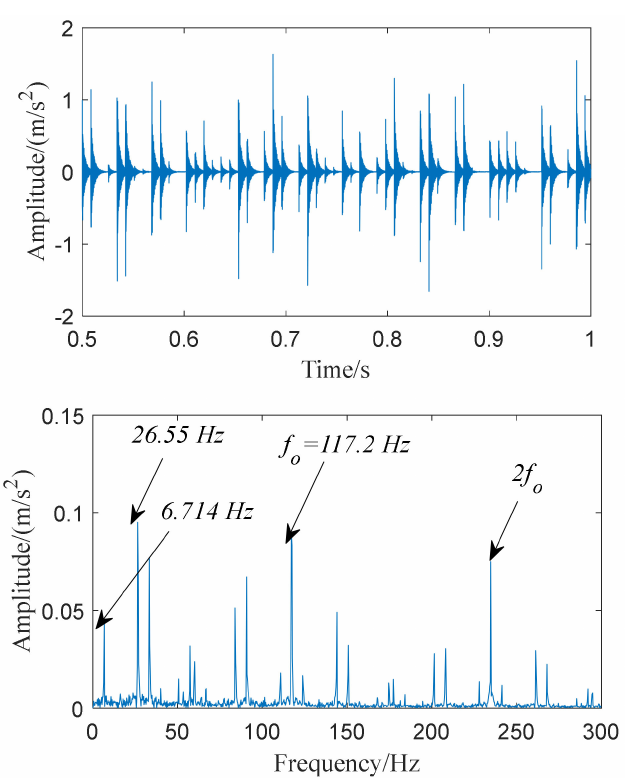
Figure 19. Time–domain waveform and spectrum of the OR fault signal (0.1 mm defect).